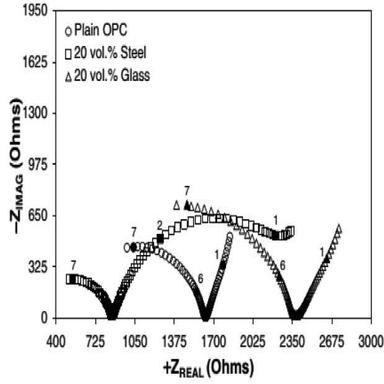
Typical Nyquist plots for cement paste with different conductive materials.